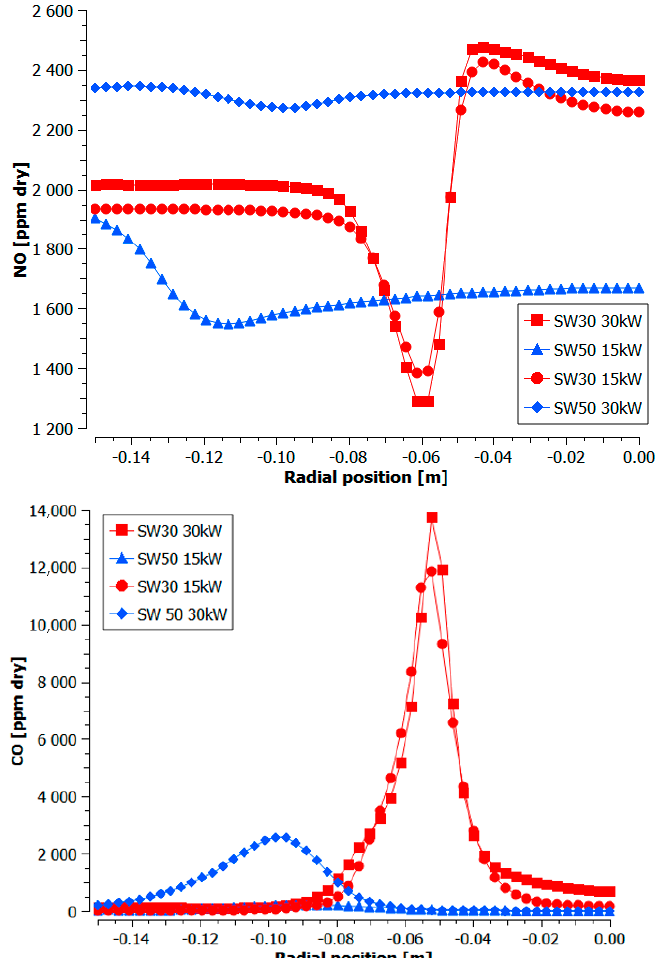
Figure 7. Comparison of the local species concentration for different swirlers and thermal load—3D modelling, Xiao, axial position 30 mm, φ = 0.71.